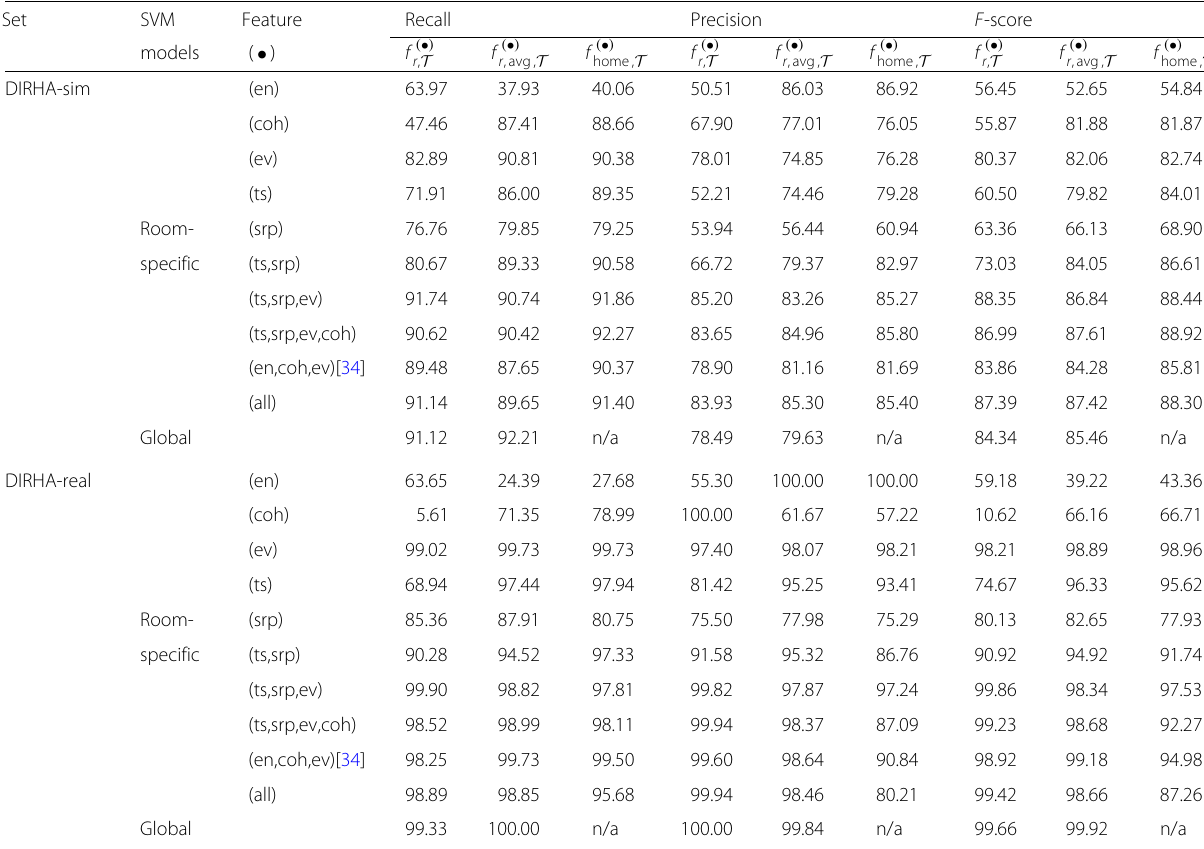
Table 4 Performance of the room discriminant features of Section 5.1 and their combinations, in conjunction with inter-room fusion (Section 5.2) and SVM modeling (Section 5.3) for the room-inside vs. room-outside speech classification task of the second stage of the proposed